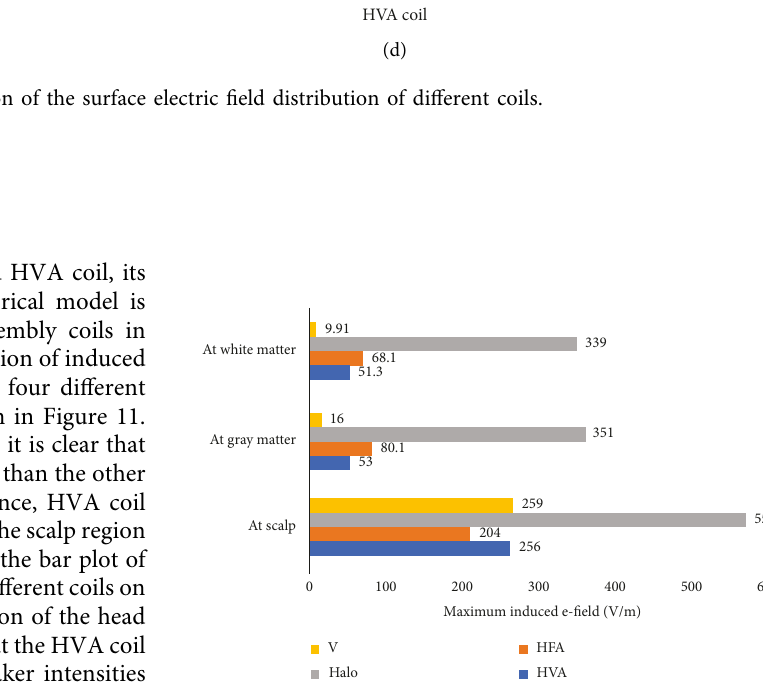
Figure 12: Comparison of the maximum induced electric field on the scalp, gray matter, and white matter of the head model for the V, Halo, HFA, and HVA